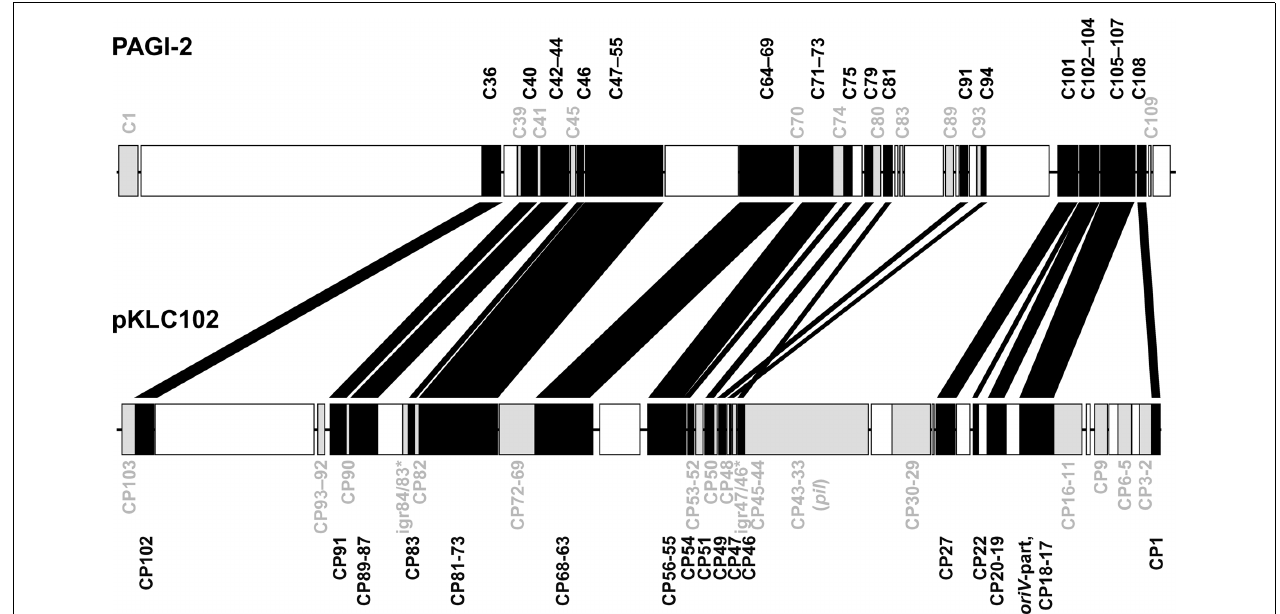
single islands (“individual cargo”). Intergenic regions (igr) marked with an asterisk indicate loci with no ORF annotated for pKLC102 but for the highly homologous sequences in other islands from this subtype. Please note that ORF C105 of PAGI-2 is homologous to DNA in pKLC102 described as a part of the replication origin oriV of this element.The other part of oriV containing 16 57bp repeats (Klockgether et al., 2004) is not conserved among the island family, not even in other islands from the pKLC102